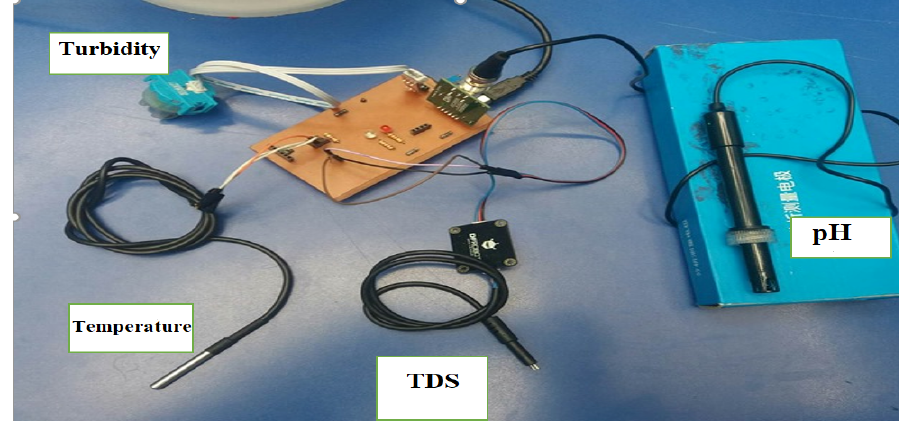
Figure 8. View of the WSN node including the four considered sensors and the